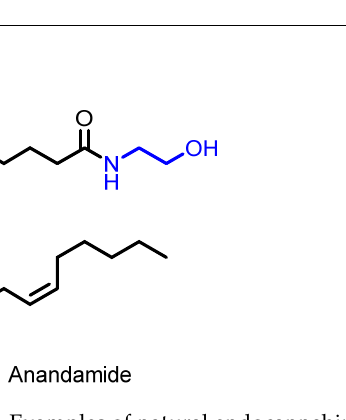
Figure 2. Examples of natural endocannabinoids.